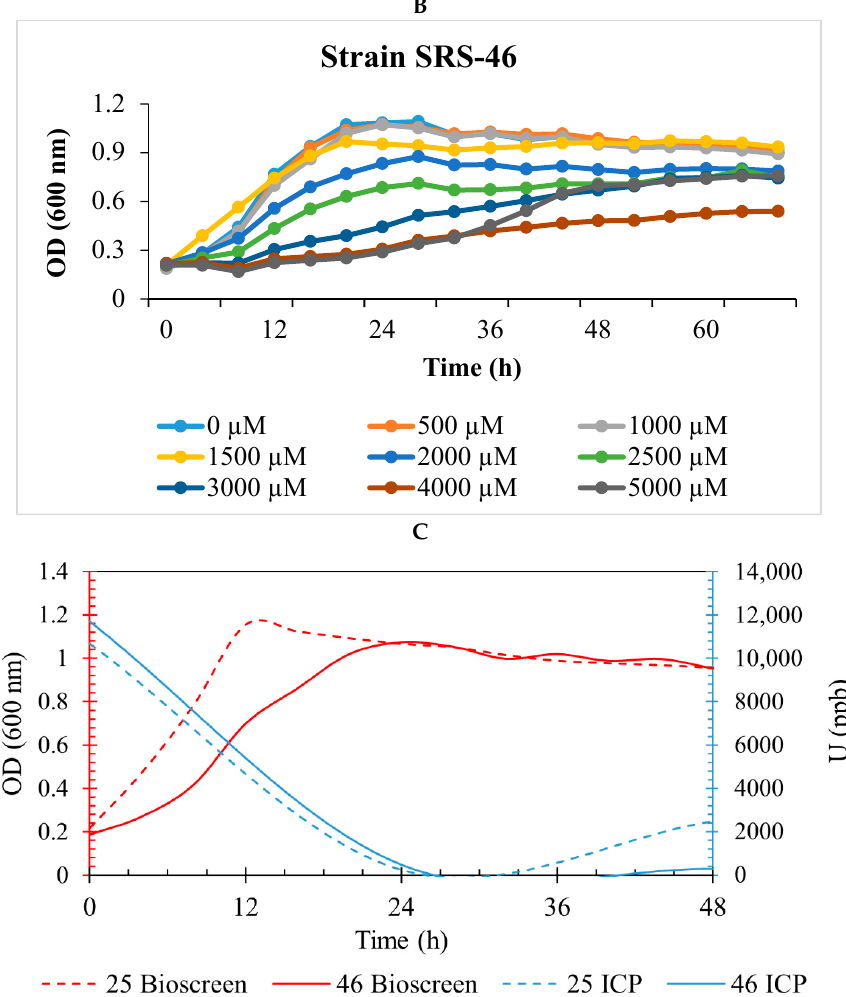
Figure 1. Shown is the resistance abilities of Burkholderia sp. SRS-25 ( A ) and SRS-46 ( B ) at uranium concentration ranging from 0 to 5000 µ M. Also shown is the growth (Bioscreen C) and concomitant depletion of uranium evaluated by inductively coupled plasma-mass spectrometry (ICP-MS) in microcosms spiked with 1000 µ M uranium ( C ); red lines depict growth at OD 600 strain along with depletion of uranium shown in blue color, respectively.